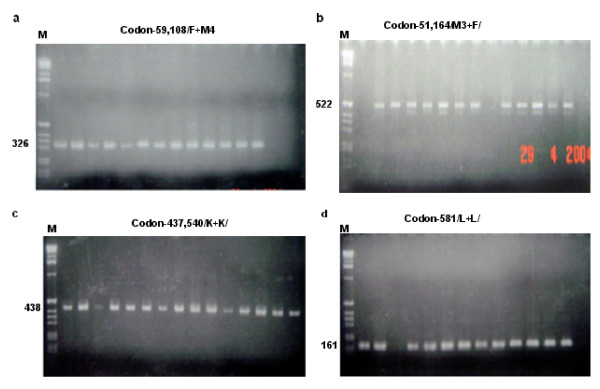
Agarose gels of the PCR products ((a) F+M4; (b) M3+F/; (c) K+K/; (d) L+L/) of the tests for the polymorphisms of dhf and dhps. Fragment sizes are in bp.